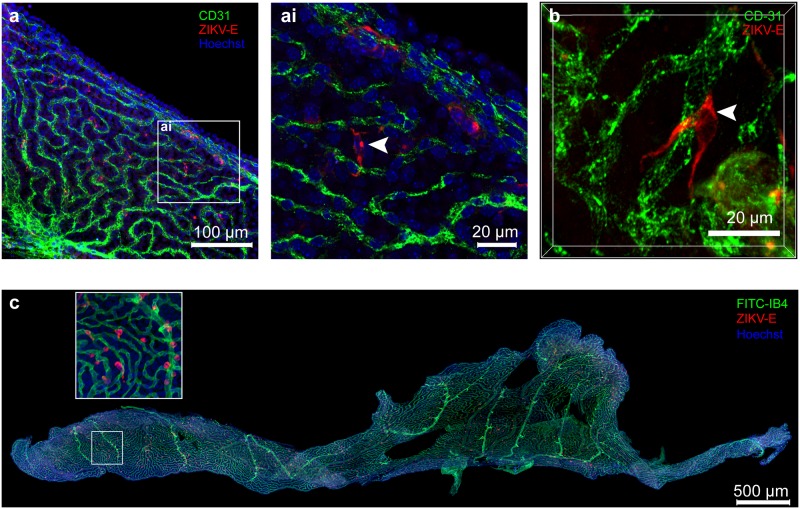
ZIKV-infected cells in the choroid plexus are tightly associated with endothelial cells.a, The lateral choroid plexuses from ZIKV-infected Ifnar-/- mice (n = 4 per time point) were harvested at 4 DPI and subjected to whole mount IFA assay. The whole tissue was stained with anti-CD31 antibody (endothelial cells, green), hu-4G2 (ZIKV envelope, red), and Hoechst 33342 (nuclei, blue) and then mounted for evaluation by confocal microscopy Scale bar = 100 μm. ai, A higher resolution image of the inset area of Fig 3 a. Scale bars = 20 μm. b, A representative image of ZIKV-infected cells tightly connected with endothelial cells. Scale bars = 20 μm. c, The lateral choroid plexus of AG129 mice infected with ZIKV (1000 p.f.u. at 4 DPI) were stained with FITC-IB4 (endothelial layer, green), hu-4G2 (ZIKV envelope, red), and Hoechst 33342 (nuclei, blue). A total of 74 images taken with a 20X objective were stitched together with Hugin image stitch software. Scale bar = 500 μm.